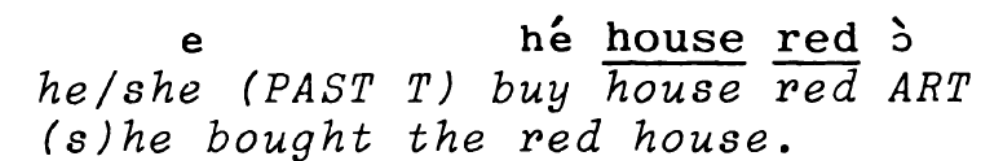
Figure 2. Insertion of English noun and adjective in Adã ŋ me order (from Nartey 1982, p. 187, example 5). Figure 3. Insertion of English noun and adjective in English order (from Nartey 1982, p. 187, example 6).